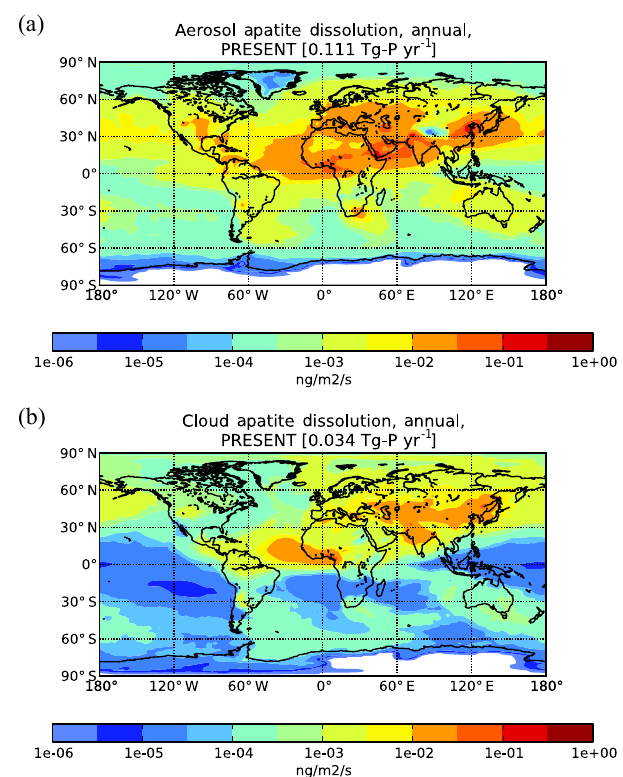
Figure 3. DIP annual fluxes (in ng-Pm − 2 s − 1 ) from apatite disso- lution (a) in aerosol water and (b) in cloud droplets, as calculated by the TM4-ECPL model for the present atmosphere (year